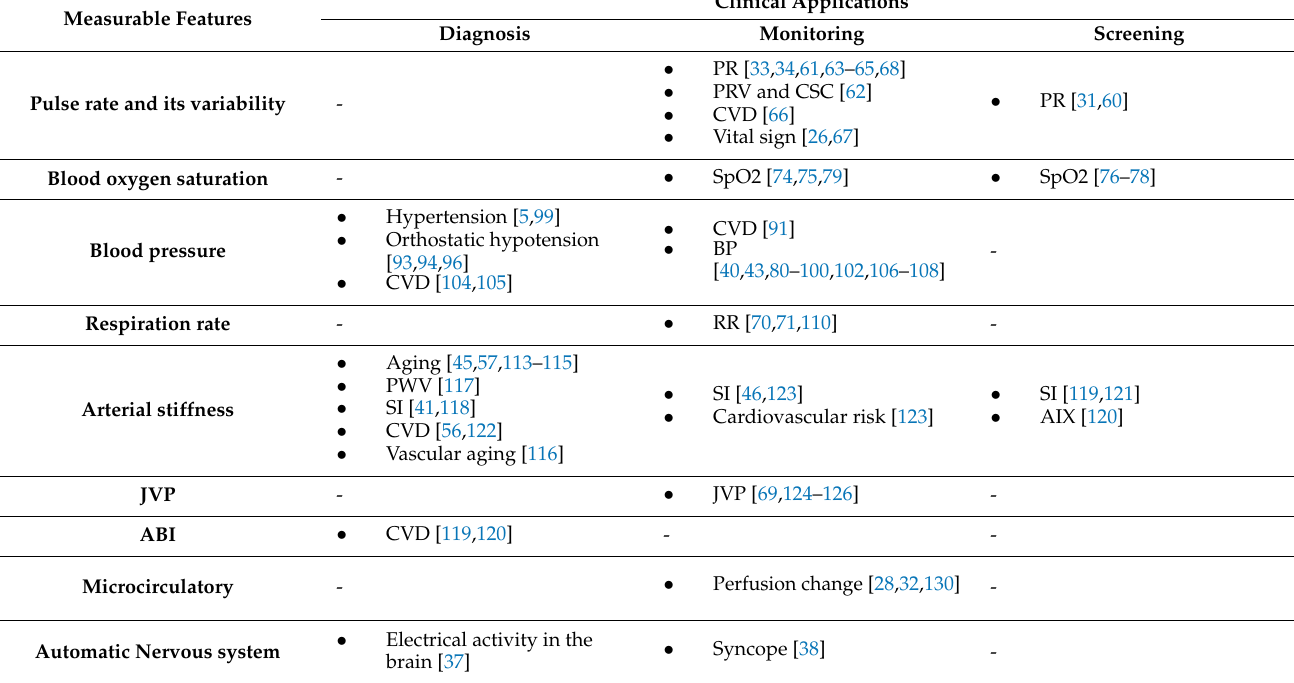
Table 1. Measurable diagnostic features from different organ systems and their clinical applications.